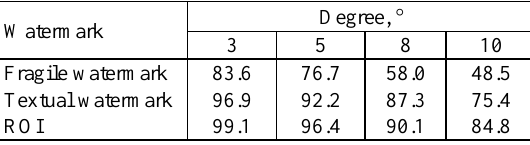
Table 3. BCR estimates under translation attacks